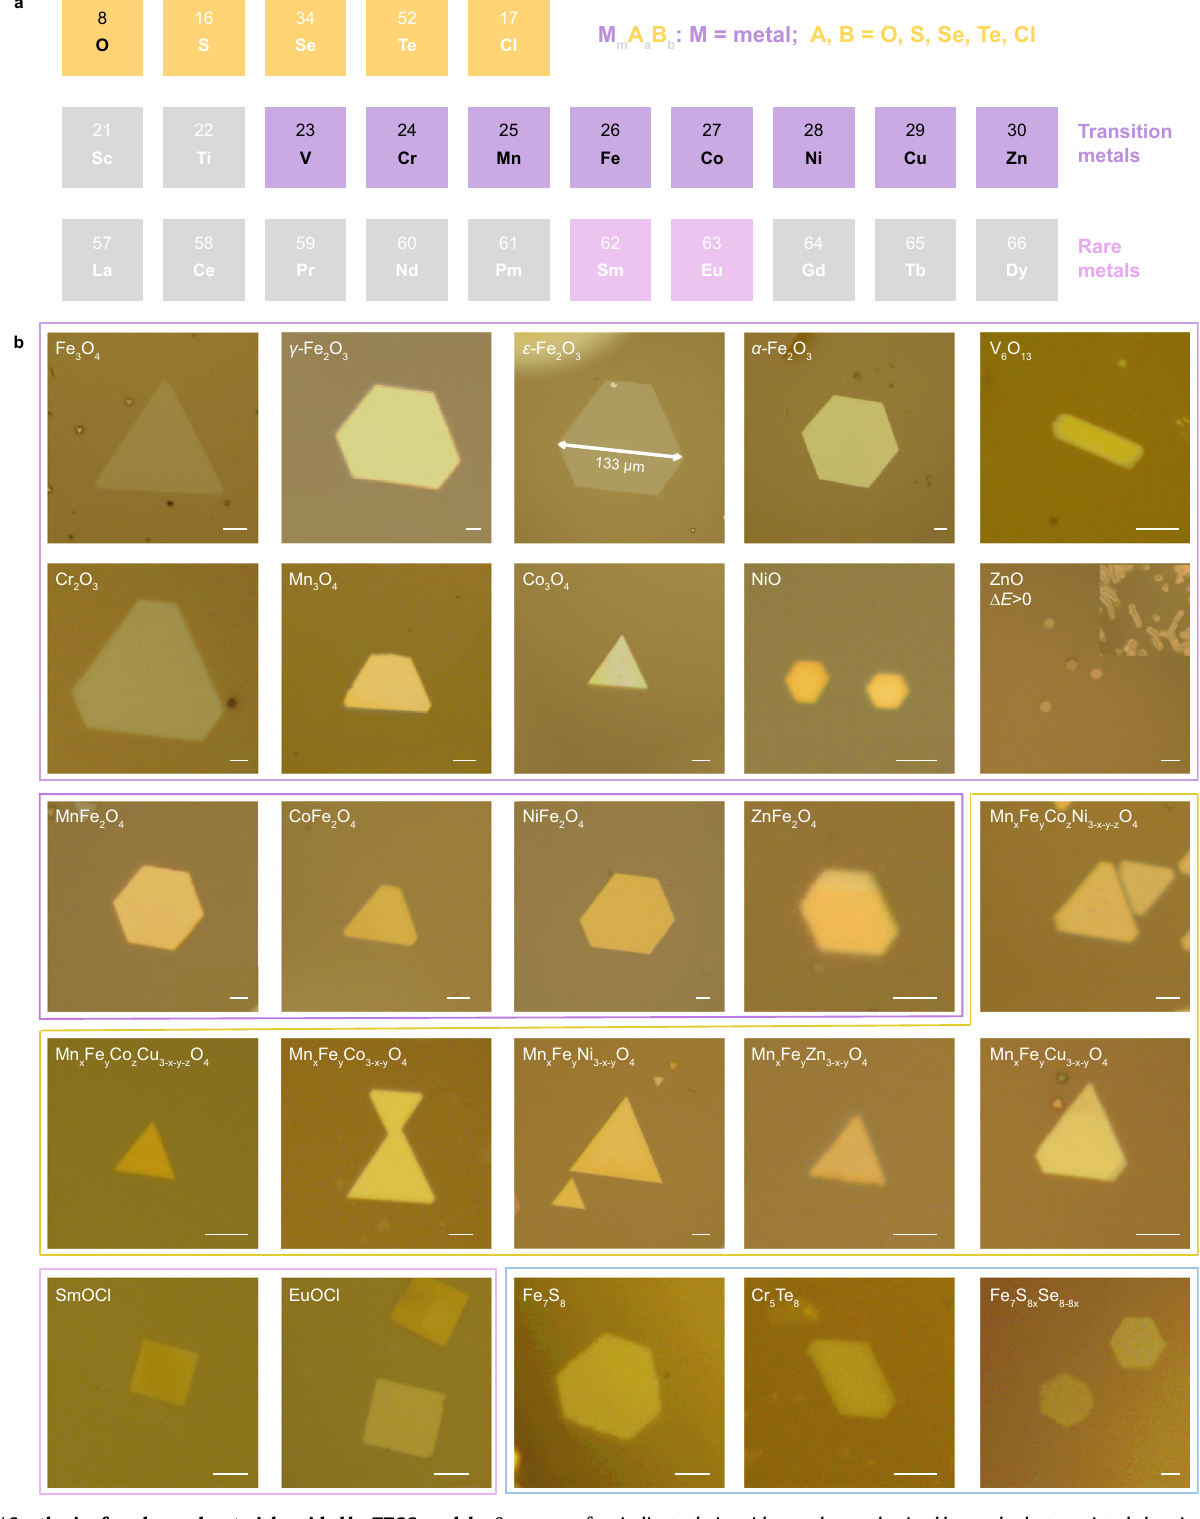
indicate theiroxides canbe synthesized by ourhydrate-assisted chemical vapor deposition (HACVD) method. m, a, and b are the corresponding stoichiometric numbers. b Optical images of as-grown materials. Scale bars, 5 μ m. Binary, ternary, and alloy oxides are outlined in lilac, purple, and yellow colors, respectively. Rare earth oxyhalides are outlined in pink and transition metal chalcogens are marked in